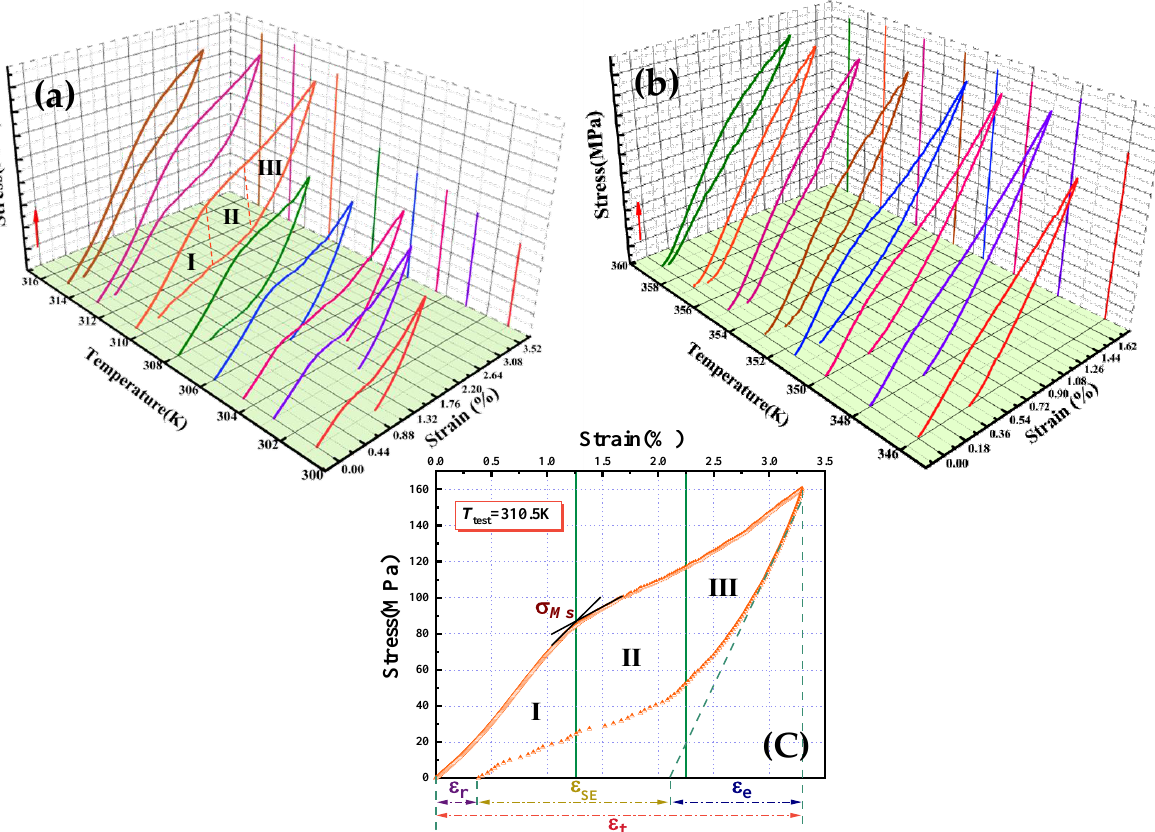
Figure 4. ( a ) SE curves of Ni 50 Mn 29 Ga 21 microwire, ( b ) Ni 50 Mn 25 Ga 20 Fe 5 microwire SE curve, ( c ) Typical curve of superelasticity.